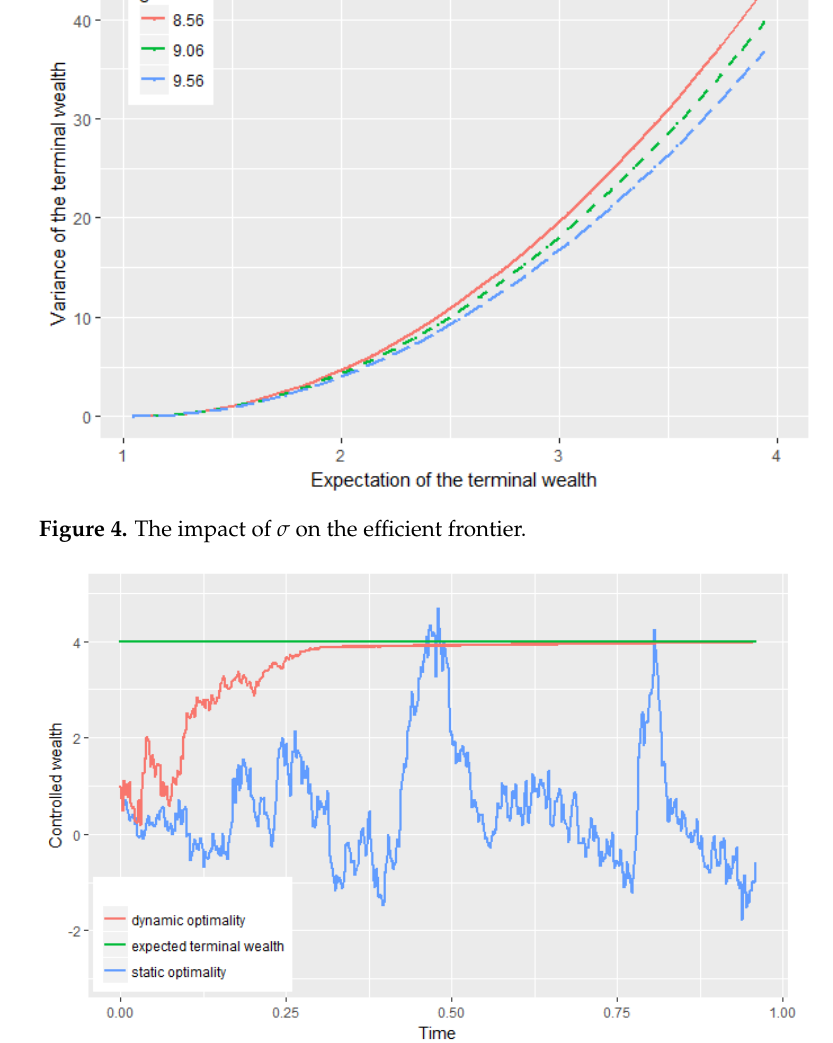
Figure 5. Statically optimal wealth X ∗